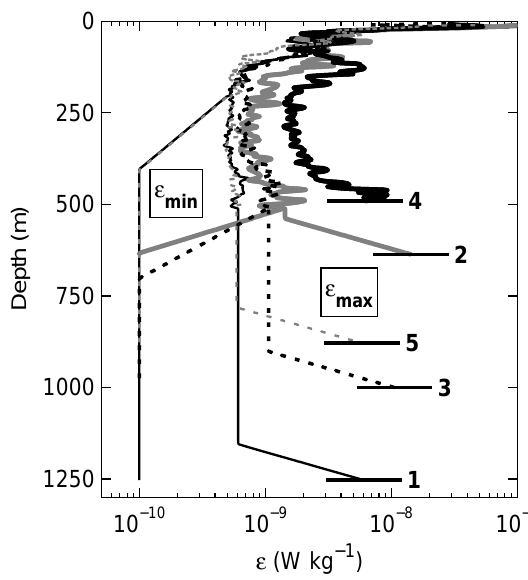
Figure 4. Dissipation rate profiles for stations 1–5. Horizontal lines with the station number indicated mark the mean echo sounder depth for the station. Observed, station-mean profiles are shown in the upper 500m. Assumed full-depth profiles used in calculating depth-integrated ε are shown for the lower bound ε min and the up- per bound ε max